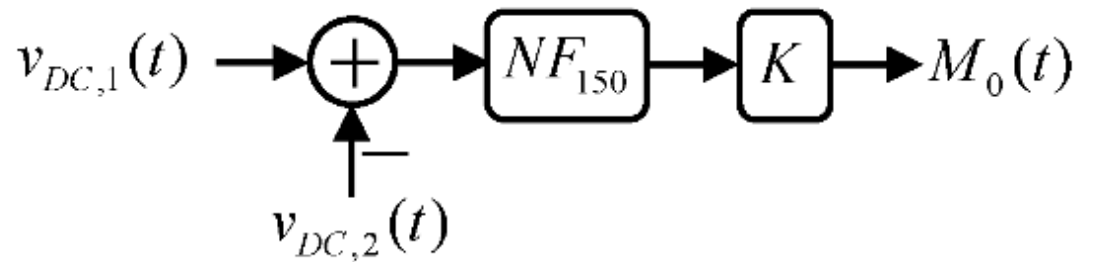
Figure 4. T-type three-phase three-level power converter. ( a ) Power stage circuitry. ( b ) The 10 KVA experimental prototype.